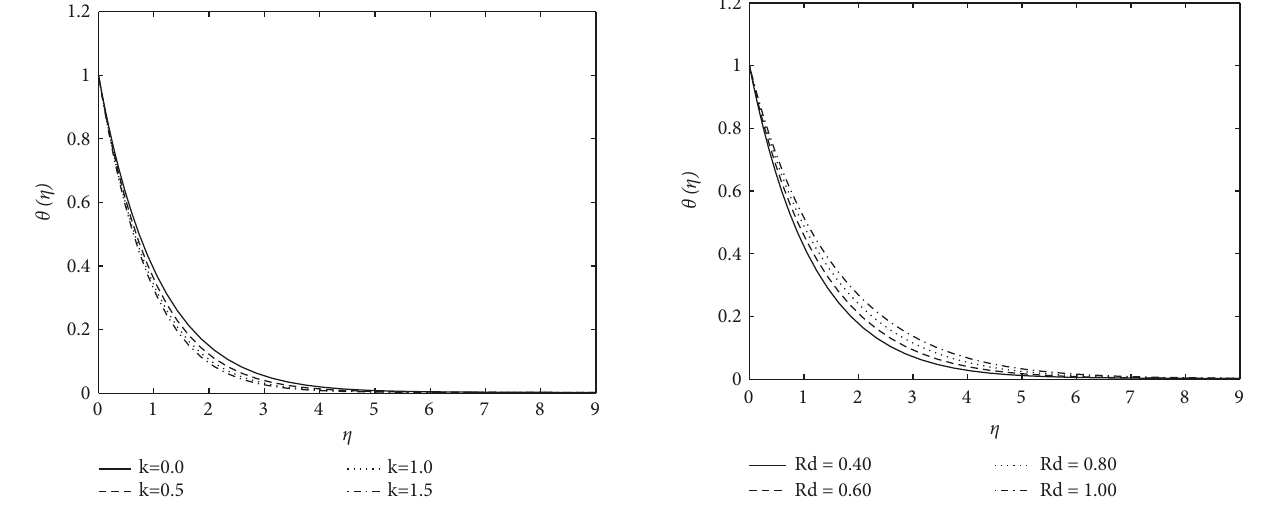
Figure 9: Change in the value of θ ( η ) for different values of